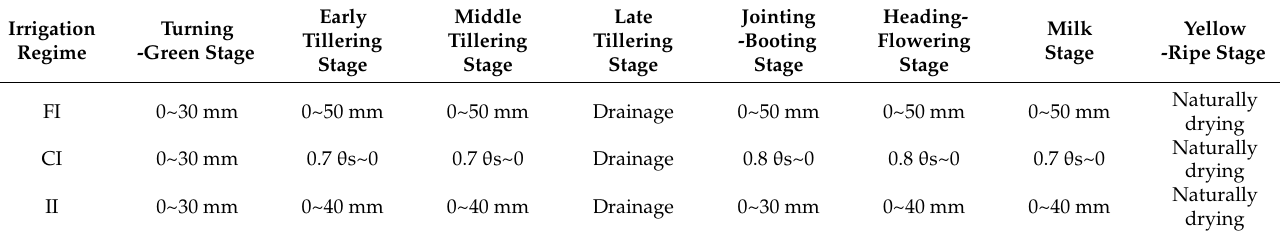
Table 1. Different water management regime at rice growth